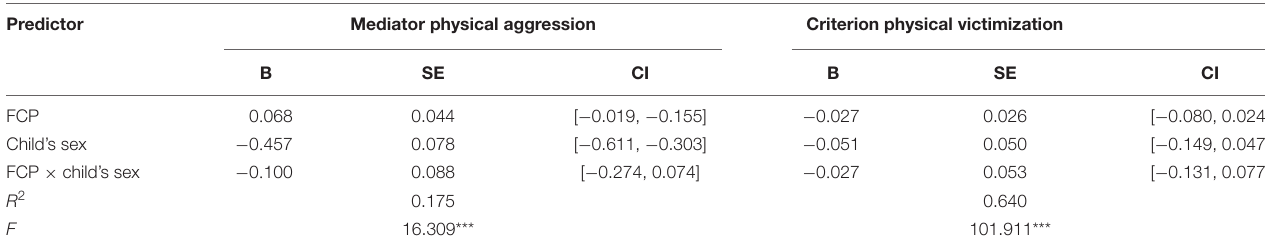
Predictor Mediator physical